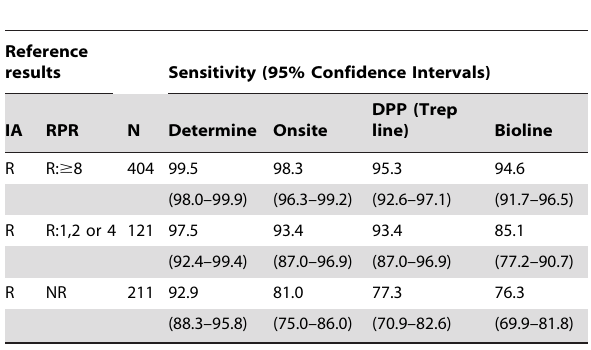
Table 5. POC test sensitivity among reference Treponemal immunoassay reactive specimens, by RPR reactivity and